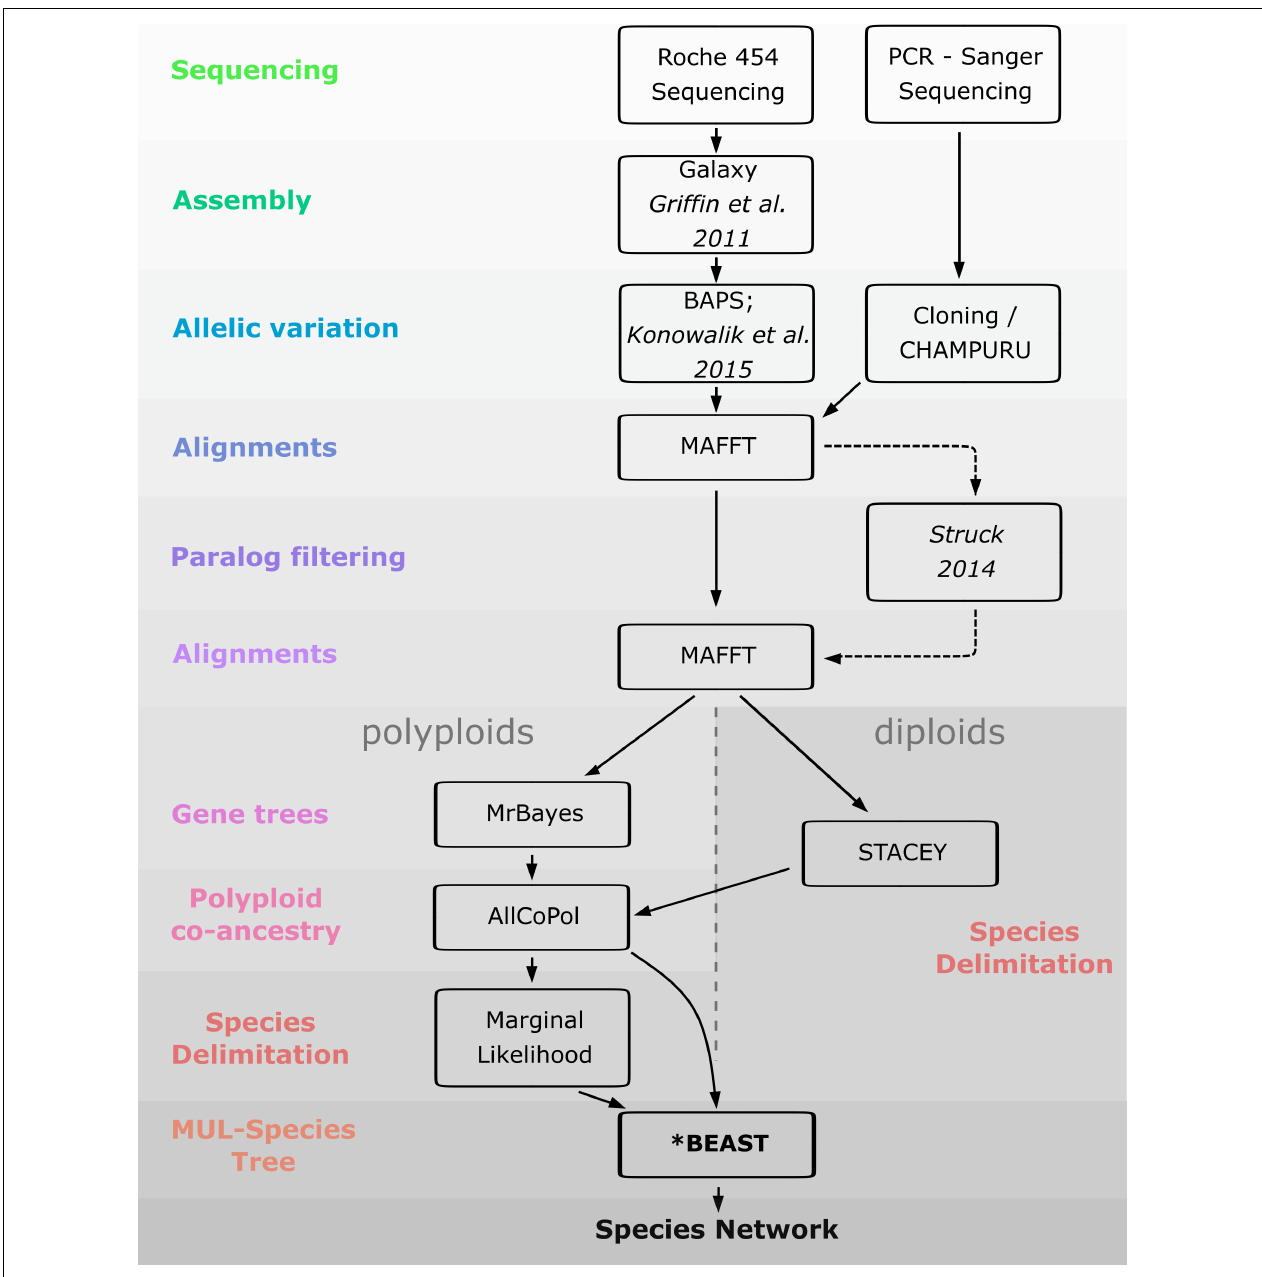
FIGURE 3 | Workflow of the analyses performed in the present study.